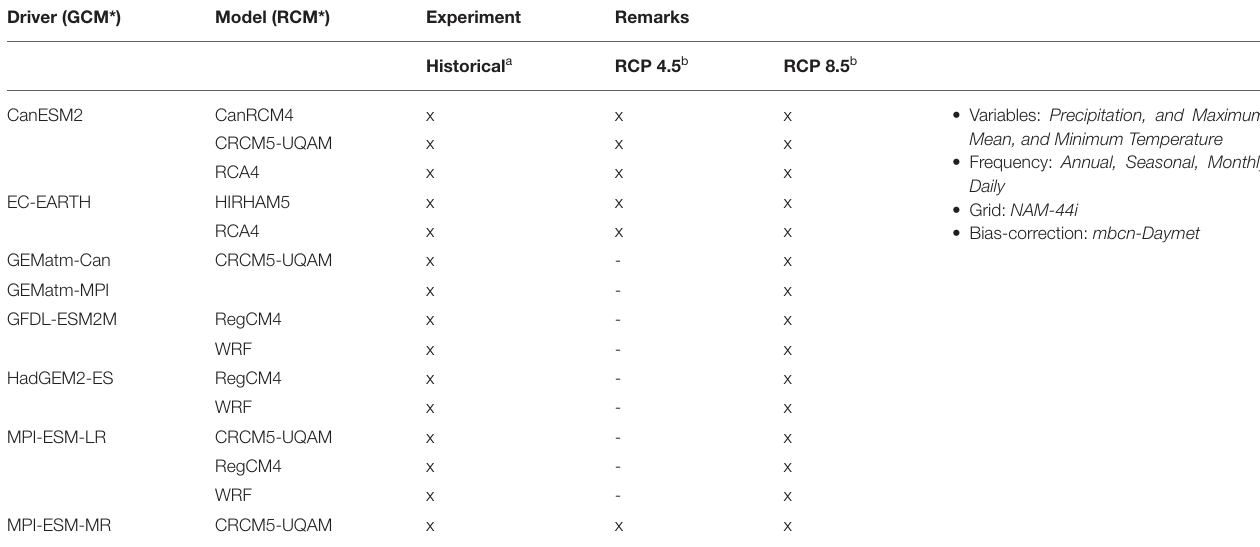
TABLE 1 | Details of the different RCM projections, as driven by different GCMs, used in this study. Driver (GCM*)